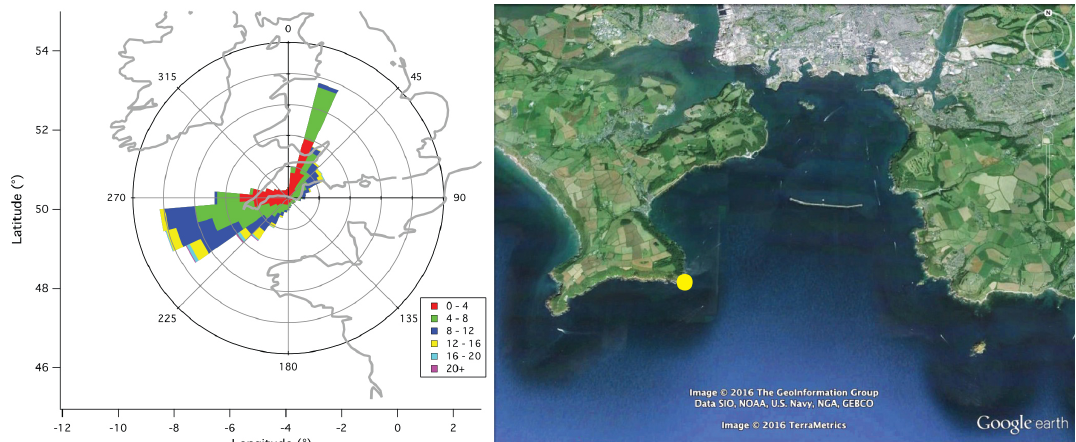
Figure 1. Wind rose at Penlee Point Atmospheric Observatory from 2014 to 2015 overlaid on a map of the British Isles (left), and a map showing the observatory (yellow circle) on the western side of the 4km wide Plymouth Sound (right). The English Channel lies between the UK and northern France. Colors on the spokes correspond to wind speeds in units of ms − 1 and concentric circles indicate frequency of occurrence in 2.5% intervals (outer circle = 12.5%). Winds predominantly came from the west/southwest at speeds of 4–12ms − 1